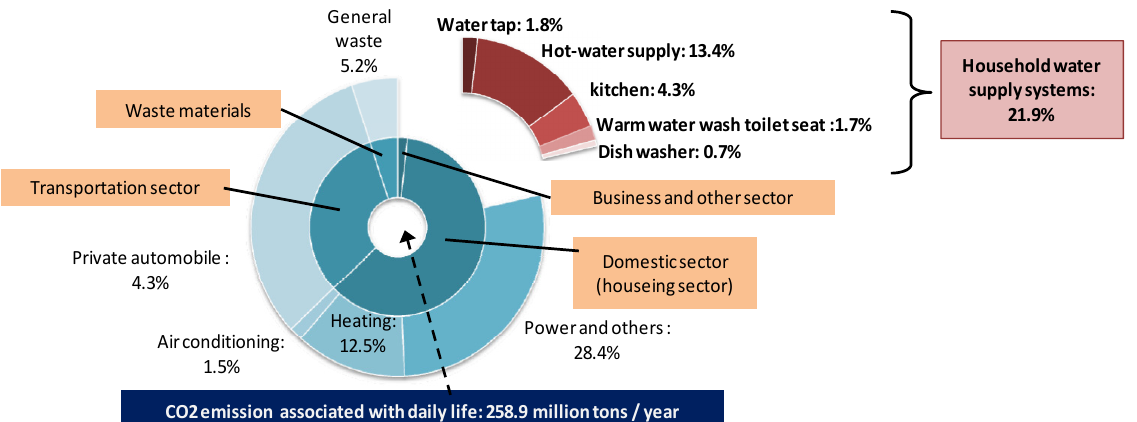
emission from Japanese 2